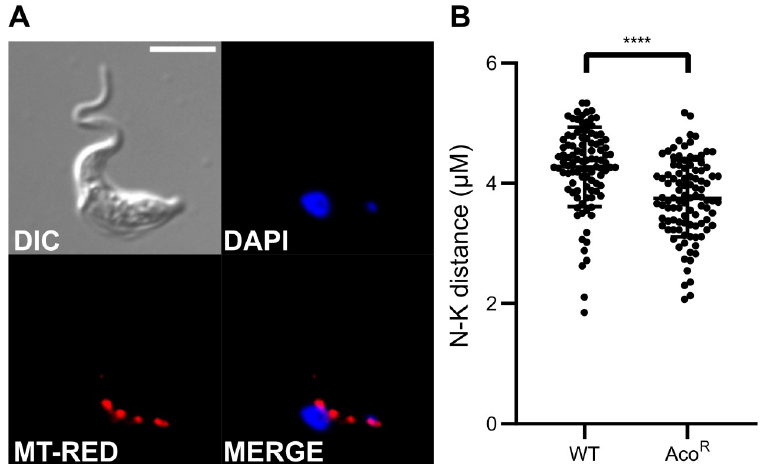
Fig 5. Microscopy analysis of AcoR cells. A) Morphology and organelle arrangement in Aco R cells was analysed by fluorescence microscopy. Overall morphology appeared to be similar to typical BSF parasites (differential interference contrast; DIC). In addition, kinetoplast DNA was localised to the posterior end of the cell (DAPI). Finally, localisation and shape of the single mitochondrion was observed to be normal (Mitotracker red; MT-RED). Scale bar